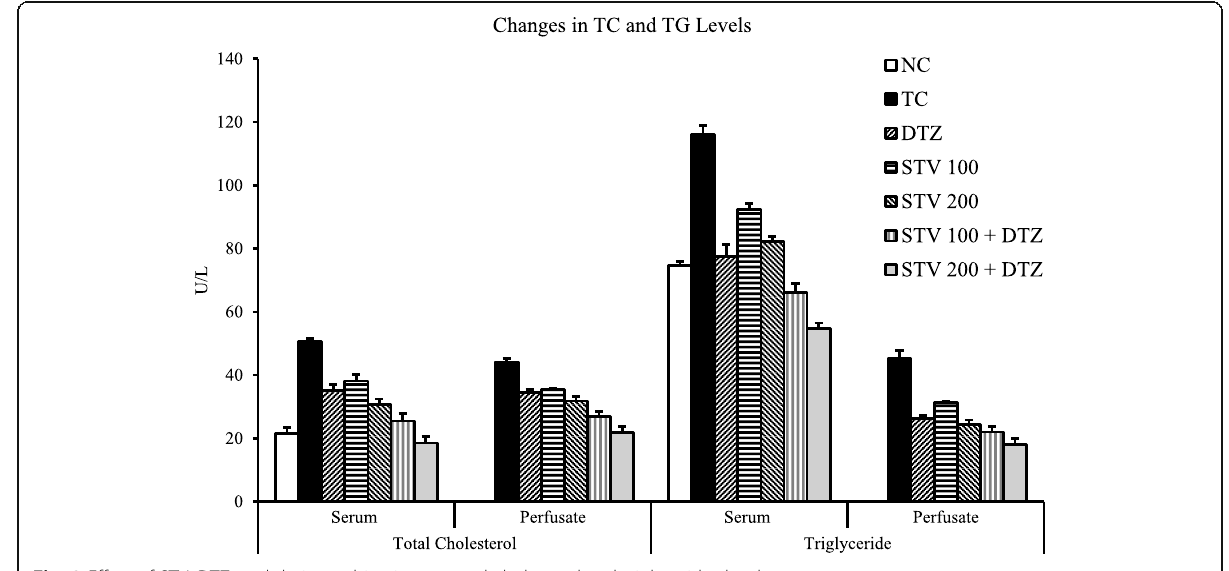
Fig. 3 Effect of STV, DTZ, and their combination on total cholesterol and triglycerides